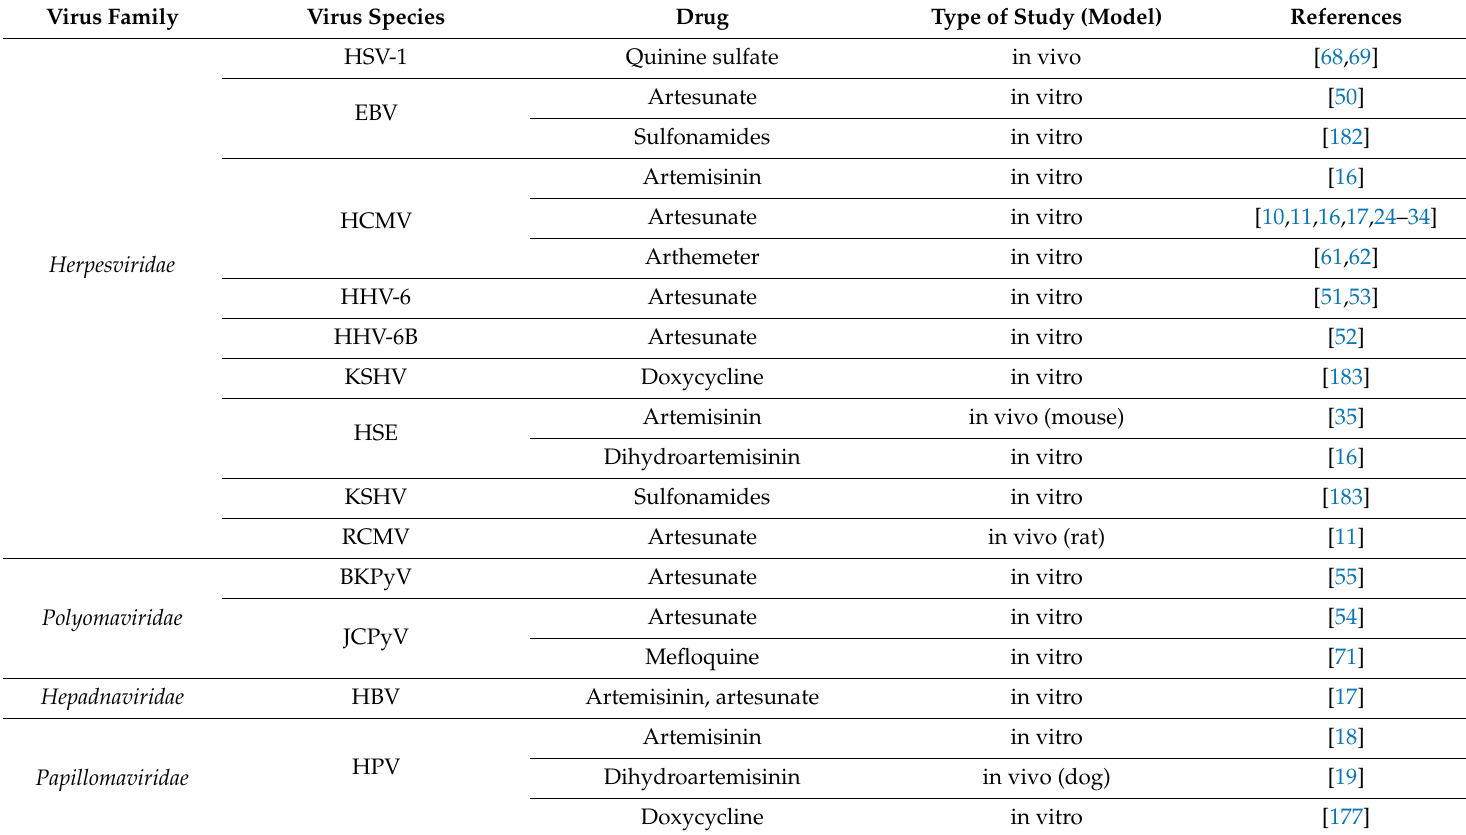
Table 3. In vitro / in vivo studies for the assessment of antimalarial drug activity against viral